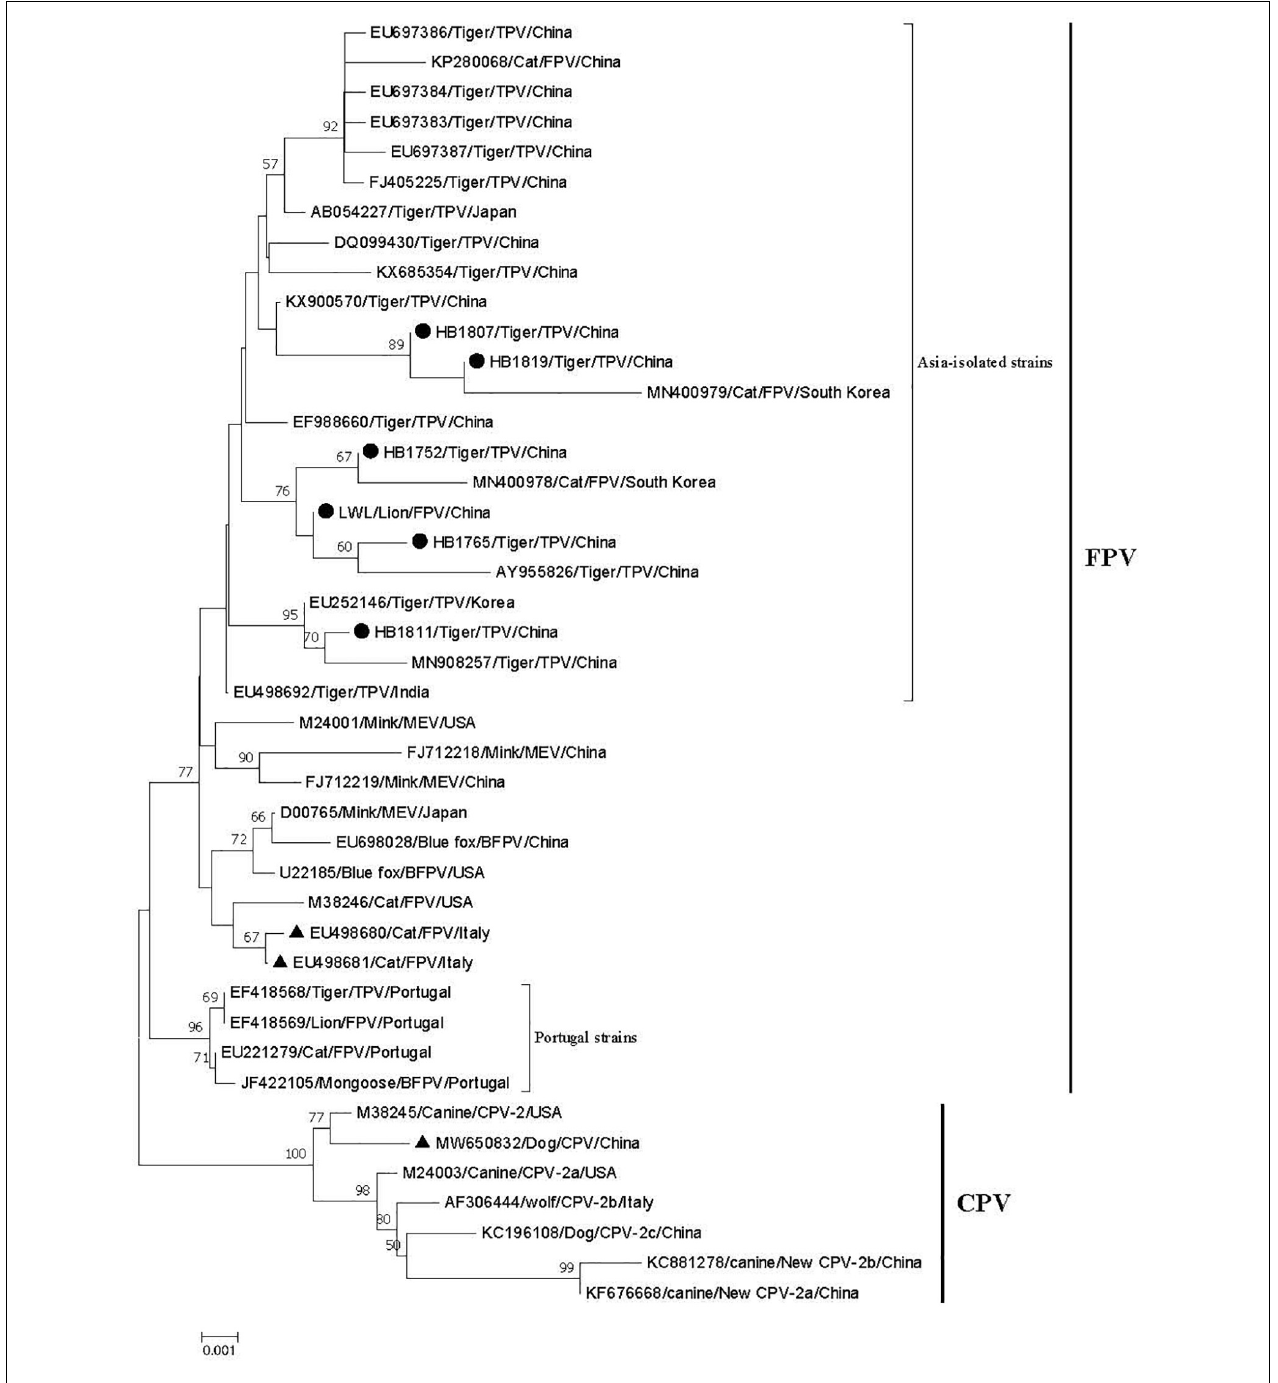
FIGURE 1 | Phylogenetic tree of six FPV partial VP2 genes compared with other references of parvovirus strains obtained from GenBank. The tree was generated using the neighbor-joining method in MEGA 7.0 using the Kimura 2-parameter model with 1,000 bootstrap values. Bootstrap values ≥ 50 at the nodes of the tree. “ ” represents the strains in this study; “ (cid:115) ” represents vaccine strains; EU498680 and EU498681 are the FPV vaccine strain; MW650832 is the CPV vaccine strain. The length of the six VP2 genes is as follows: HB1807: 973 bp; HB1752: 790 bp; HB1765: 984 bp; HB1819 bp: 973; HB1811: 1683 bp; LWL: 825 bp. (cid:32)